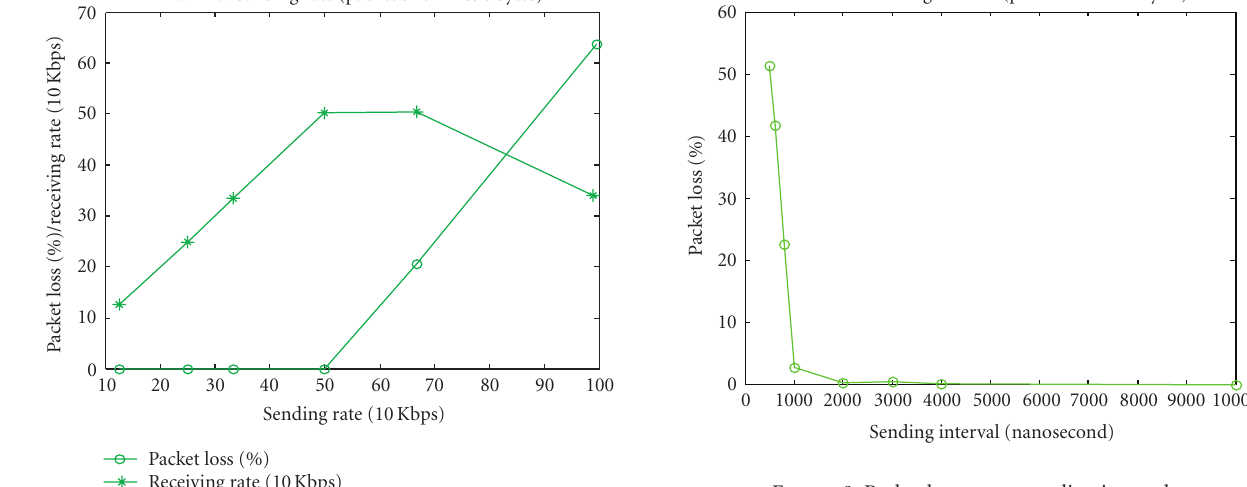
Figure 9: Packet loss versus sending interval.